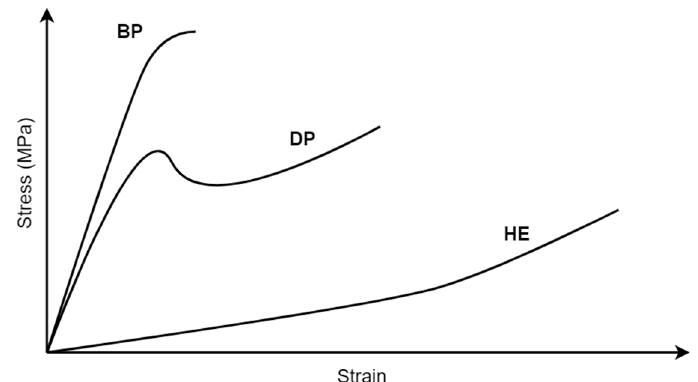
Figure 13. Behavior of different types of polymeric materials subjected to loads according to [126], BP—brittle polymer (glassy polymer, low-temperature thermoset), DP—ductile polymer (semi- crystalline, plastic, high-temperature thermoplastic, HE—highly elastic